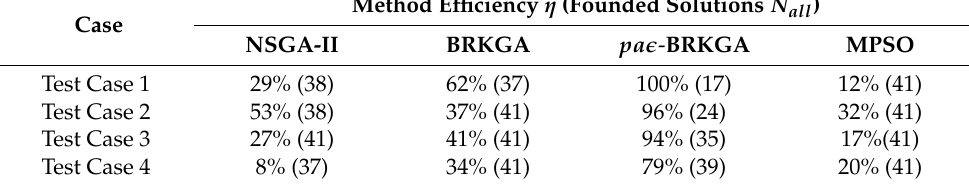
Table 3. Methods Efficiency for different test